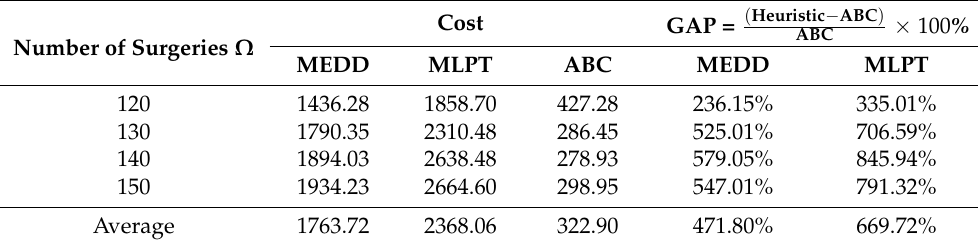
Table 3. The performance of the heuristics and the ABC algorithm for large problem instances.